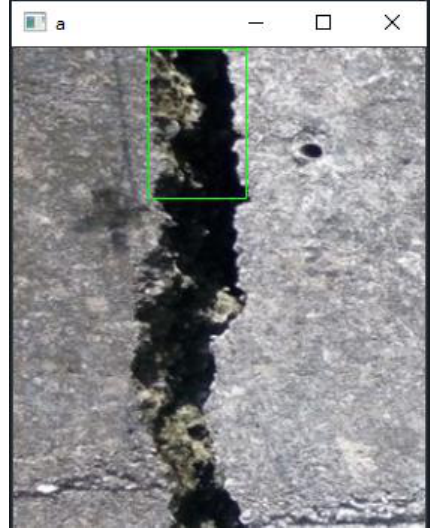
Figure 6. Schematic diagram of ground truth capture.